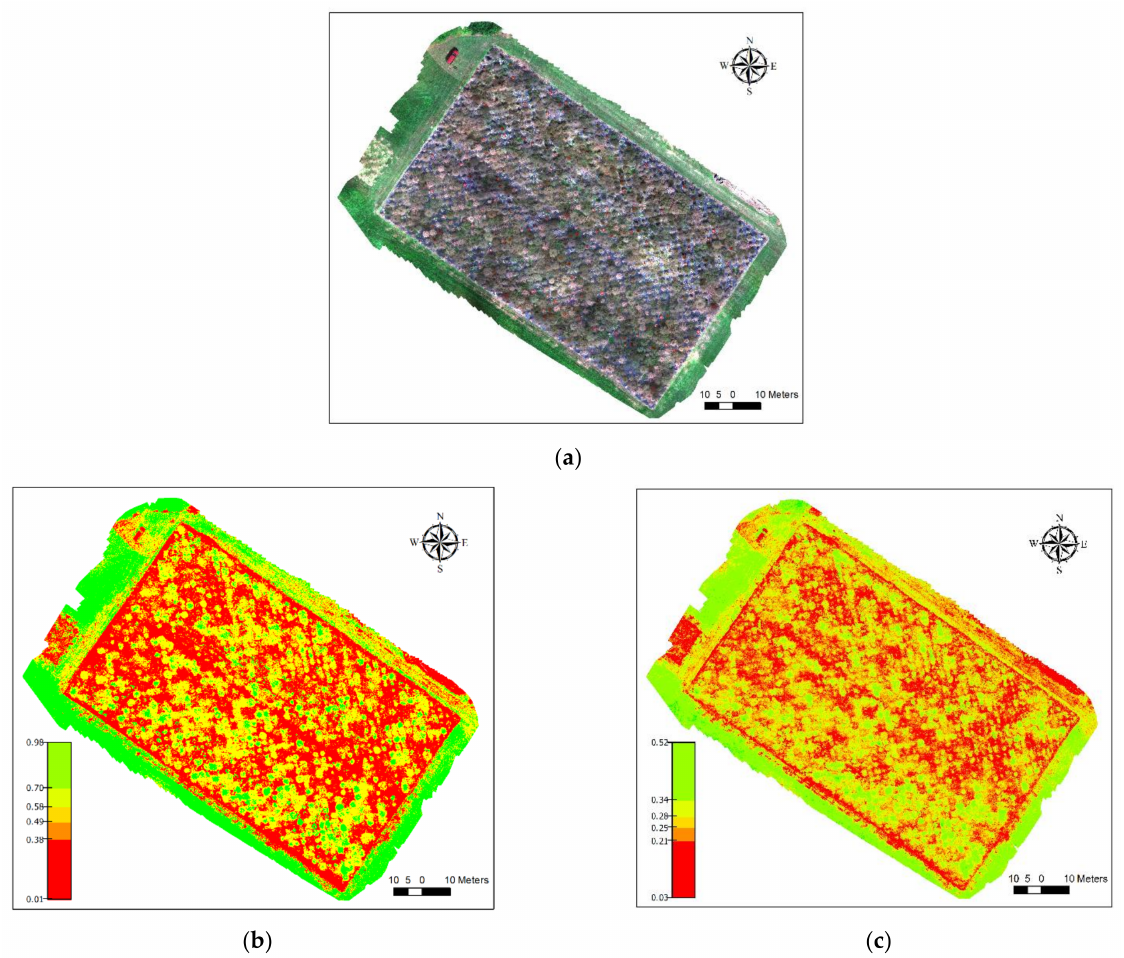
Figure 9. RedEdge bands (RGB) composite overlay with ground data. The green color of the two vegetation index maps represents higher leaf chlorophyll content compared to the red color that represents lower content of chlorophyll in leaves. ( a ) Map of the switchgrass field experiment made with the multispectral camera. ( b ) normalized difference vegetation index (NDVI) vegetation index map of the study area. ( c ) normalized difference red edge (NDRE) vegetation index map of the study area.